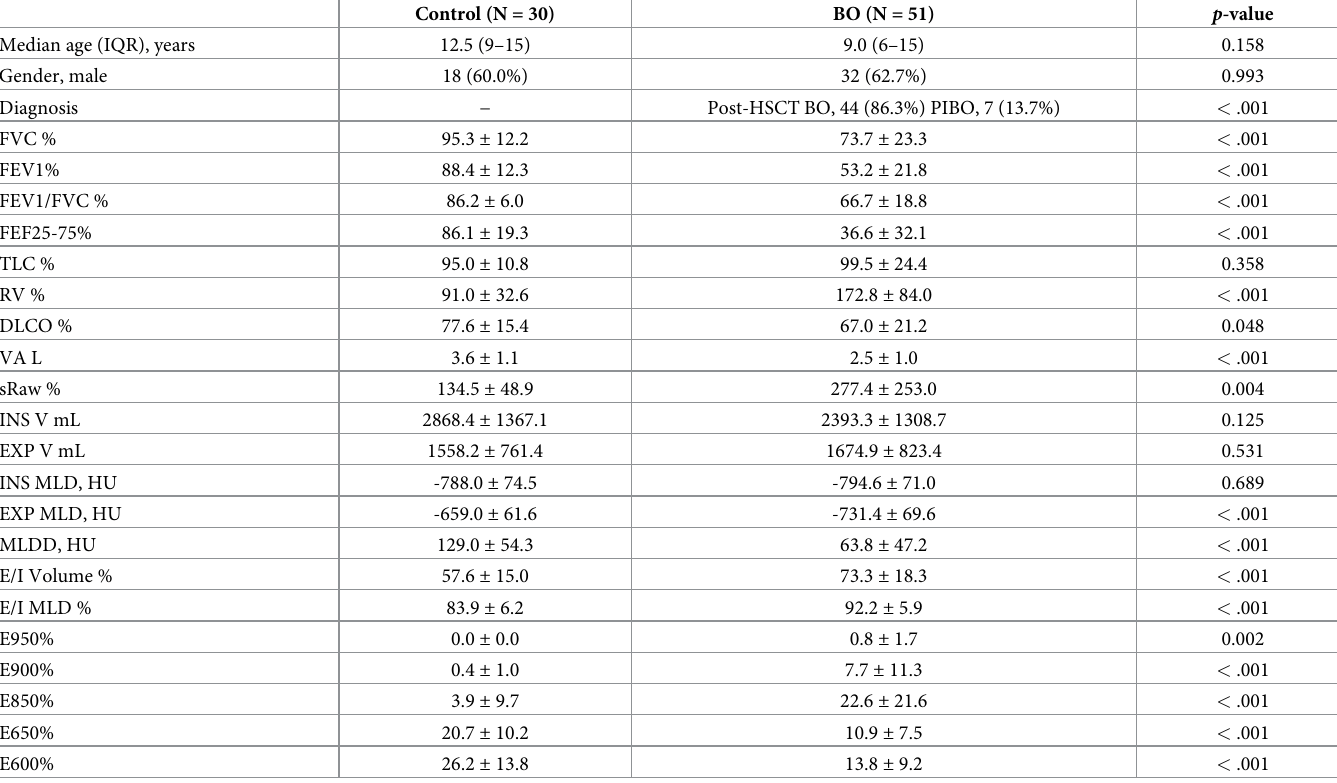
Table 1. Patient characteristics in all